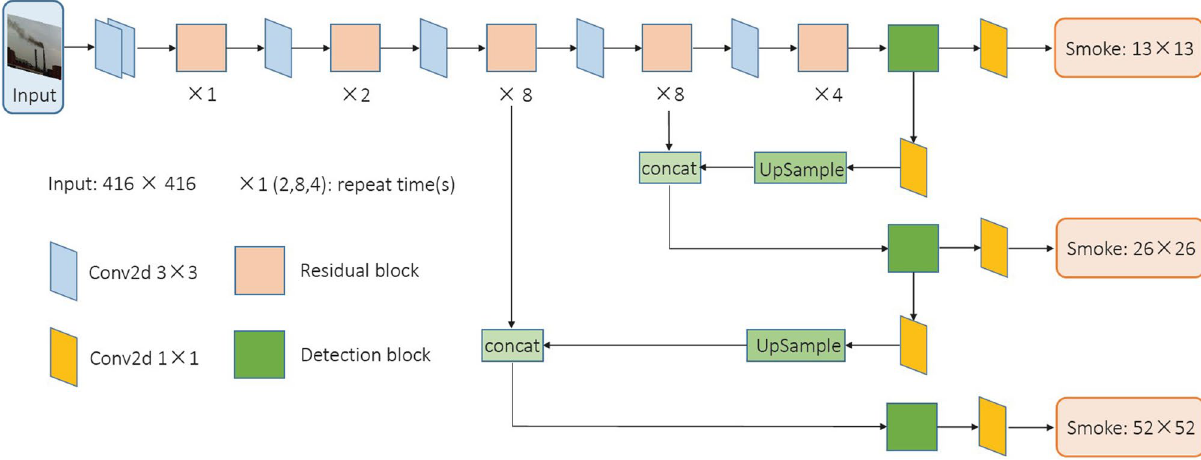
Figure 1. Network structure of the baseline model. It’s based on YOLO-V3 backbone. The network input is the 416 × 416 smoke image and output has three-scale detections with the binary smoke